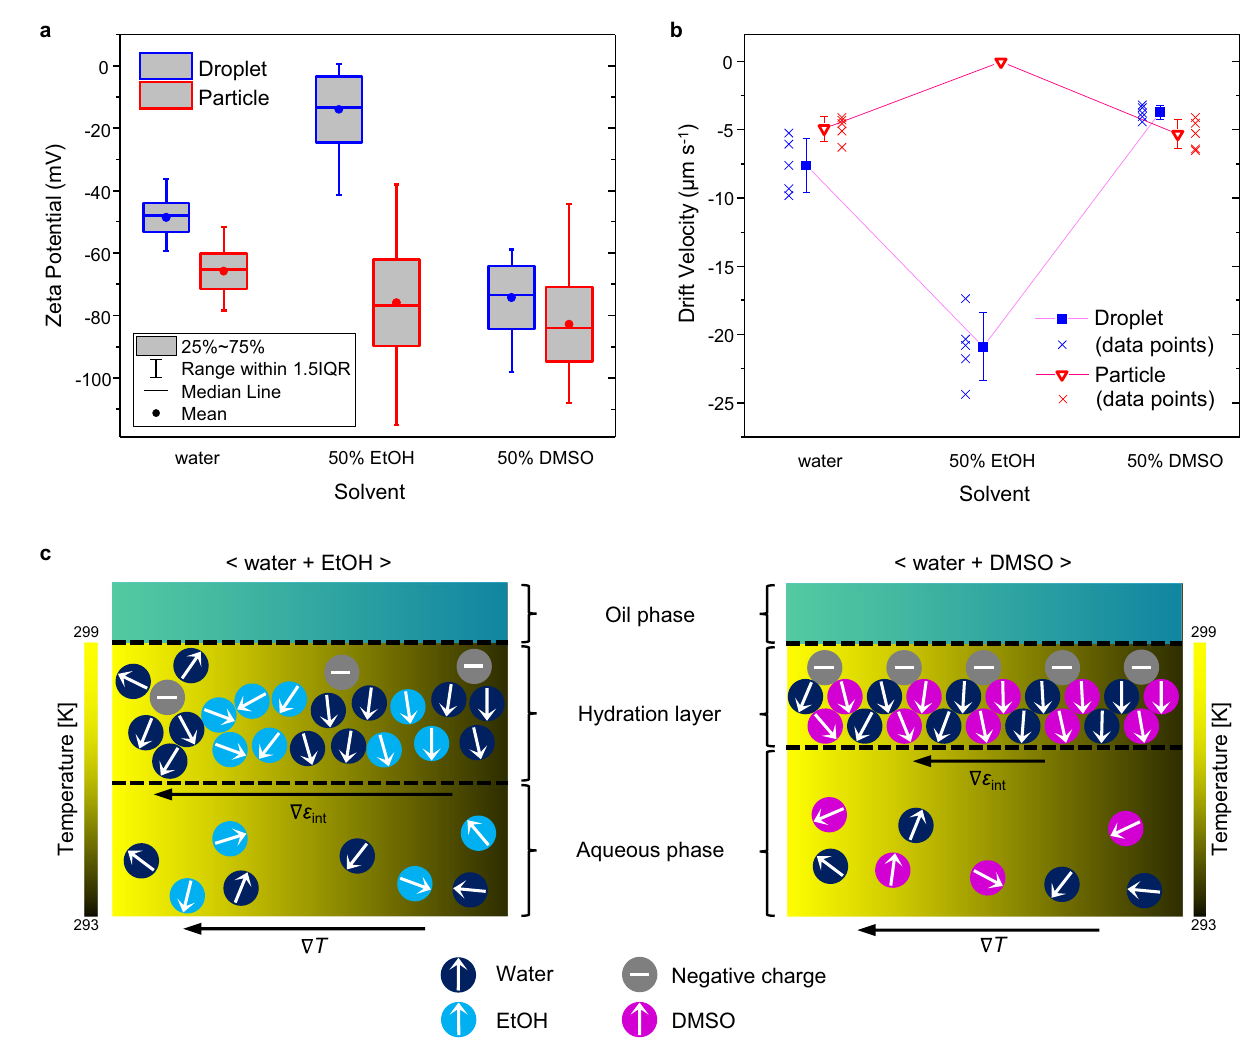
Fig. 3 Comparison between droplet and particle systems and solvent-dependent scheme of the water/oil interface. a Zeta potential (obtained from zeta potential distributions, counts > 3 × 10 5 , error bars: 1.5 interquartile range (IQR)) and b drift velocity of PS beads (red) and PFP droplets (blue) (mean ± standard deviation, n = 5, cross symbols: individual data points). c Schematic illustration of the hydration layer in different solvent environments. EtOH destabilizes negative charges owing to weak dipole-charge interactions and weak hydrogen bonding with water, forming a diffuse, inhomogeneous, and therefore, thermally responsive interface. The strong complexation of DMSO with water constructs a rigid interface that reduces its thermal responsiveness. Source data are provided as a Source data fi